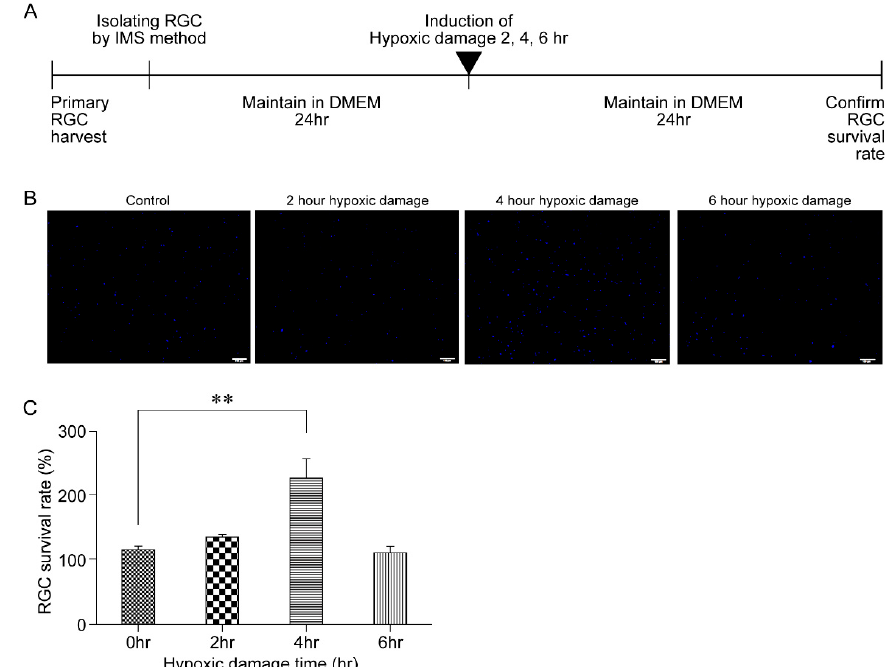
Figure 2. Effects of hypoxic preconditioning. ( A ) After inflicting hypoxic damage using the CO 2 chamber, retinal ganglion cells (RGCs) were maintained for 24 h in a defined medium. After 24 h, the cell survival rate was compared. ( B ) Representative images of RGCs after exposure to hypoxic conditions for 2, 4, and 6 h. Scale bar, 100 µ m. ( C ) The survival rate of RGCs after exposure to hypoxic conditions for 2, 4, and 6 h. Data in the columns indicate the mean survival rate ± SD. Differences in RGC survival rates are indicated (** p < 0.01).